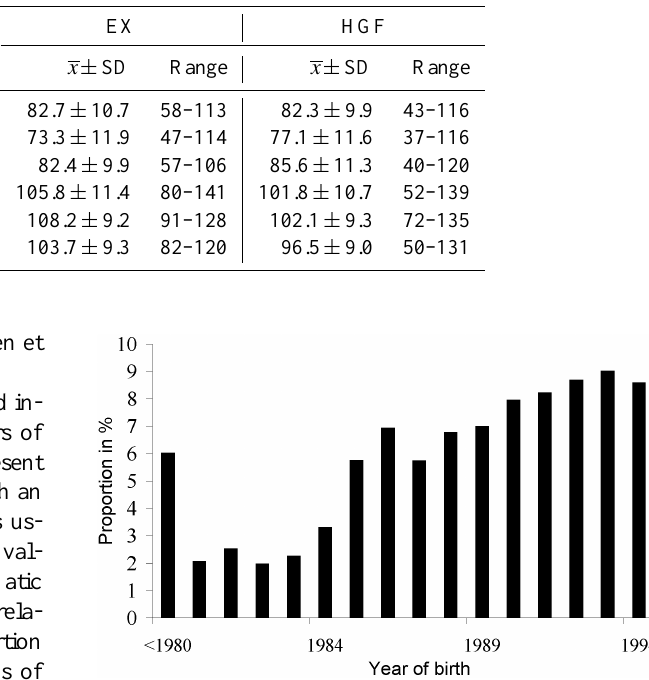
Figure 1. Distribution of the sires by their birth